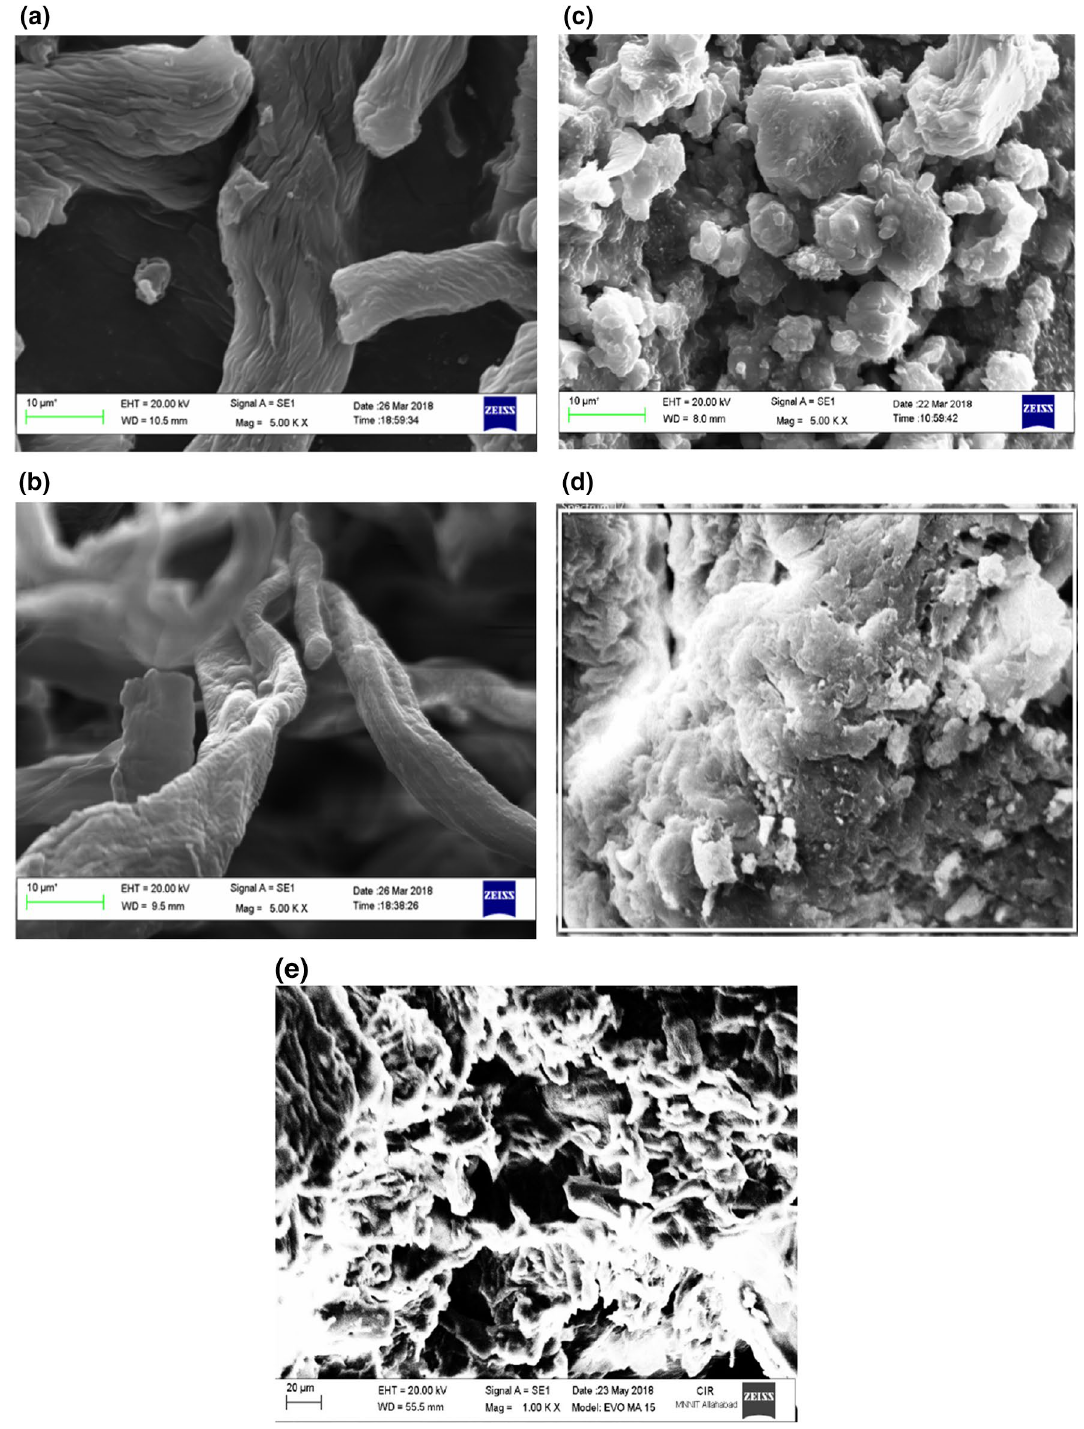
Fig. 7 a SEM of synthetic CMC, b SEM of laboratory-made CMC (bagasse), c SEM of bio-polymer gel bead made from laboratory-made CMC (bagasse), d SEM of bio-polymer gel bead made from synthetic CMC and e SEM of bagasse activated